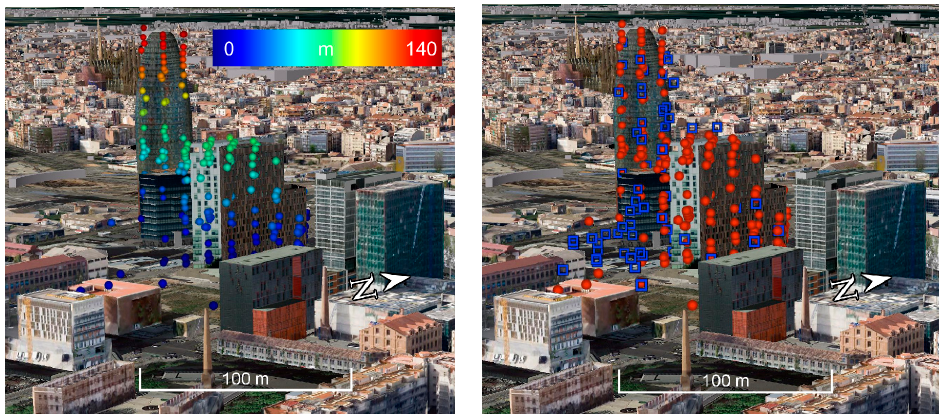
Figure 8. 3D view of the second test area with superimposed the TomoSAR height map on the left image; single (red) and double (blue) scatterers on the right image.